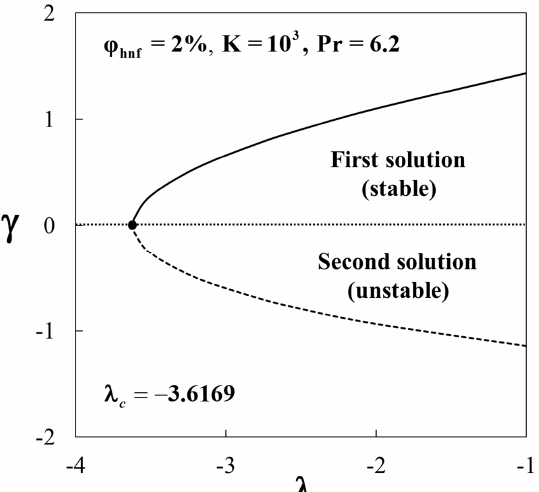
Figure 10. Variation of the smallest eigenvalues 𝛾 against the mixed convection parameter 𝜆 .